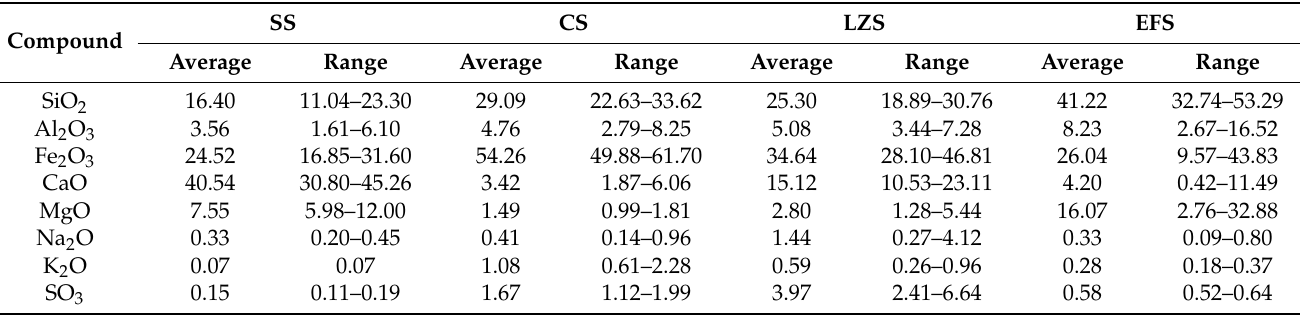
Table 1. Chemical components of these metallurgical slags